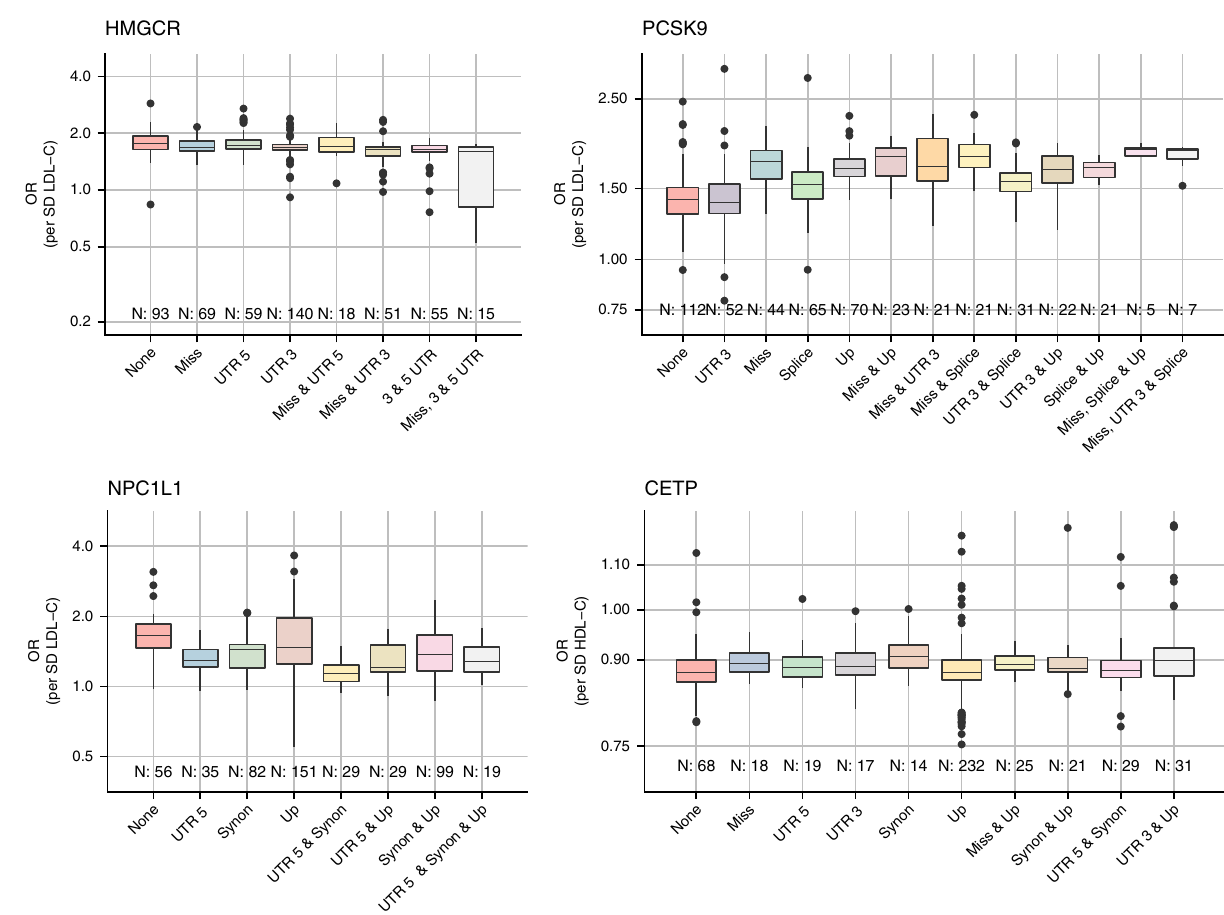
Fig. 2 Instrument selection related variation in the point estimates of drug target Mendelian randomisation studies on the lipid ’ s association with CHD. Each estimate is based on randomly (500 iterations) selecting 4 SNPs out of 17 HMGCR , 30 PCSK9 , 21 NPC1L1 , 36 CETP candidate variants. Lipids data were used from the GLGC and linked to coronary heart disease data from CardiogramPlusC4D. estimates were grouped by the inclusion of instruments with worsted predicted functional or regulatory consequence; categories occurring less than fi ve times were removed. Any pairwise LD was accounted for using the 1000 genomes ‘ EUR ’ reference panel and a generalised least squares method 17 . The boxplots depict quartiles 1, 2 (median), and 3 as a box, with the whiskers presented as vertical bars and values ±1.5 times the interquartile range as